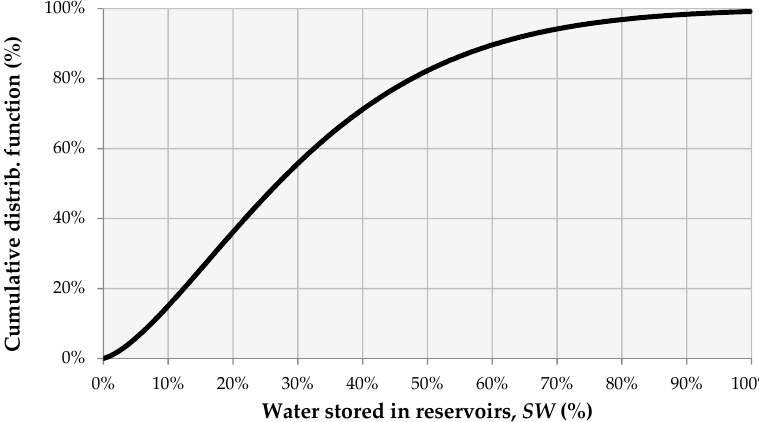
Figure 1. Weibull CDF for water stored in reservoirs in the sub-basin of Regulación General (GRB).